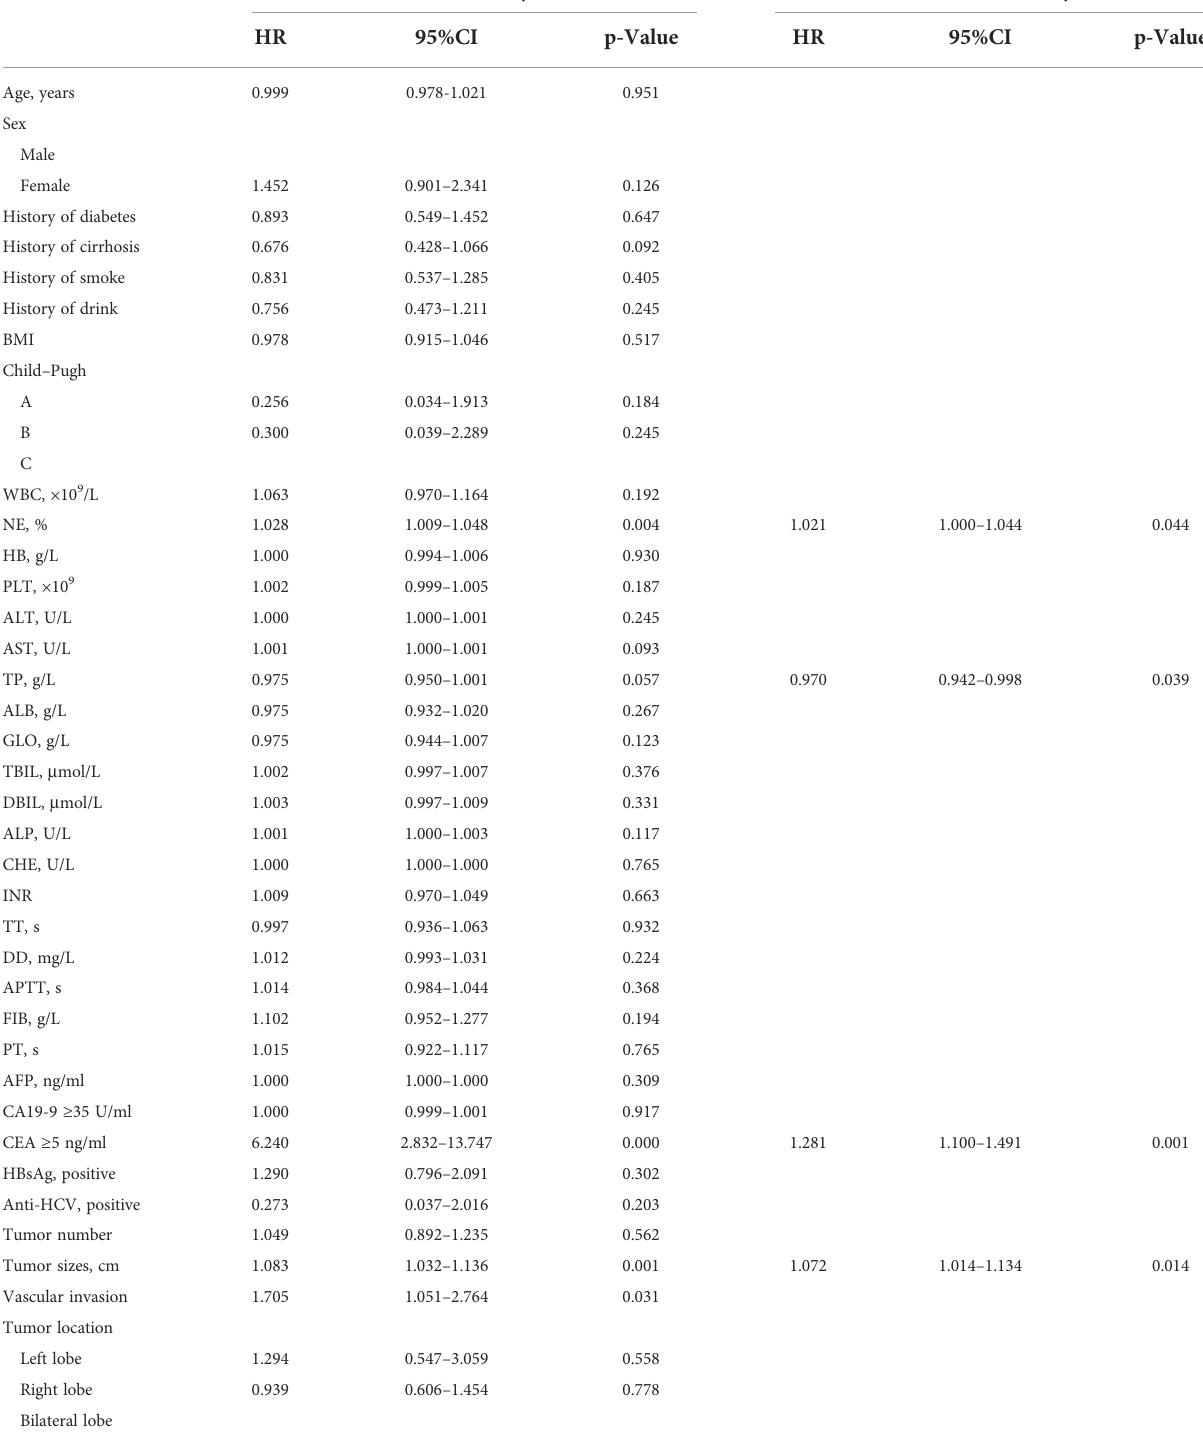
TABLE 4 Univariate and multivariate analysis for predicting EHM in followed up